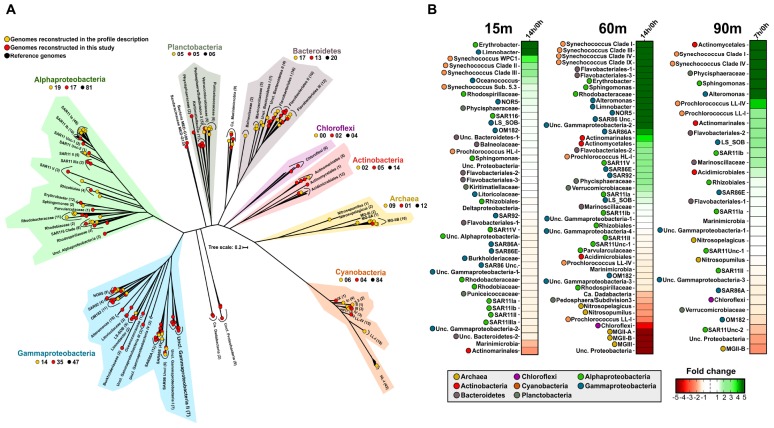
(A) Phylogenetic analysis of the 445 genomes that recruit in any of the samples. A maximum likelihood genome tree was constructed with 100 bootstraps using 262 conserved proteins. Branches in the tree are sorted and colored according to their taxonomy. Metagenome-assembled genomes (MAGs) reconstructed in this study are indicated as red circles and those recovered in a previous study (Haro-Moreno et al., 2018) in yellow. Black circles show reference genomes. (B) Metagenomic recruitment (≥ 99% identity) of genomes that recruited at least three RPKGs in any of the samples. Genomes are sorted with colored dot according to their taxonomy.